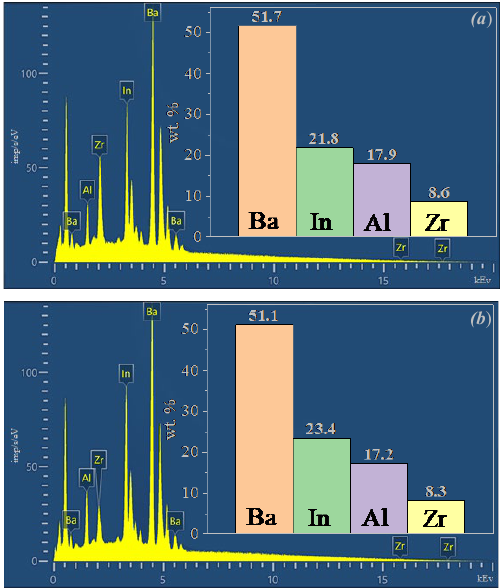
Figure 3. Scanning electron microscope (SEM) images for the powder samples Ba 5 In 2 Al 2 ZrO 13 ( a ) and Ba 5 In 2.1 Al 2 Zr 0.9 O 12.95 ( b ).